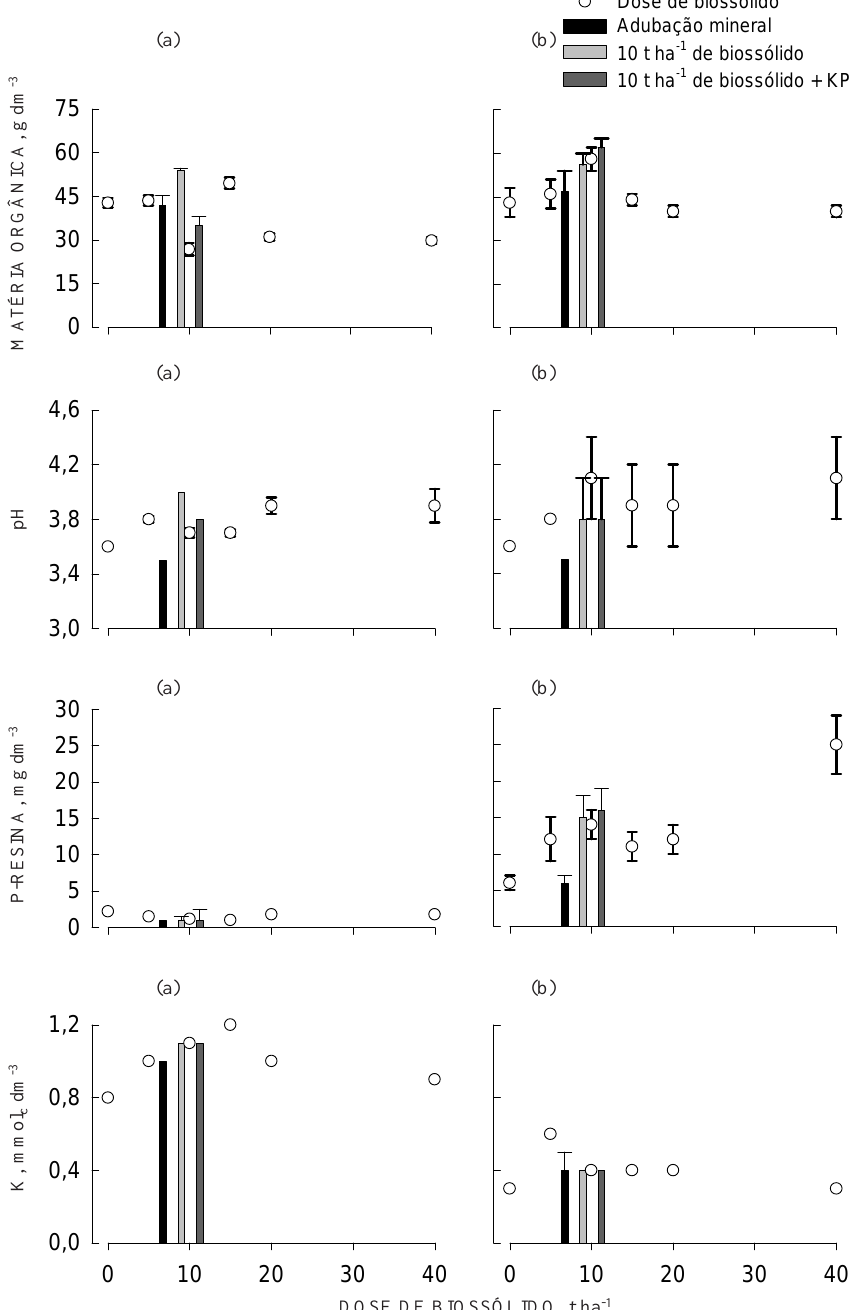
Figura 1. Teores de matéria orgânica, pH e teores de P-resina e de K trocável (média ± erro-padrão), camada de 0-5 cm, nas entrelinhas do povoamento de Eucalyptus grandis em resposta às doses crescentes de biossólido, com suplementação de K (biossólido + KCl = 165 kg ha -1 de K), às aplicações de 10 t ha -1 de biossólido, sem suplementação de K e com suplementação de K e P, e à adubação mineral sem biossólido aos (a) 6 meses e (b) 13 meses da aplicação do